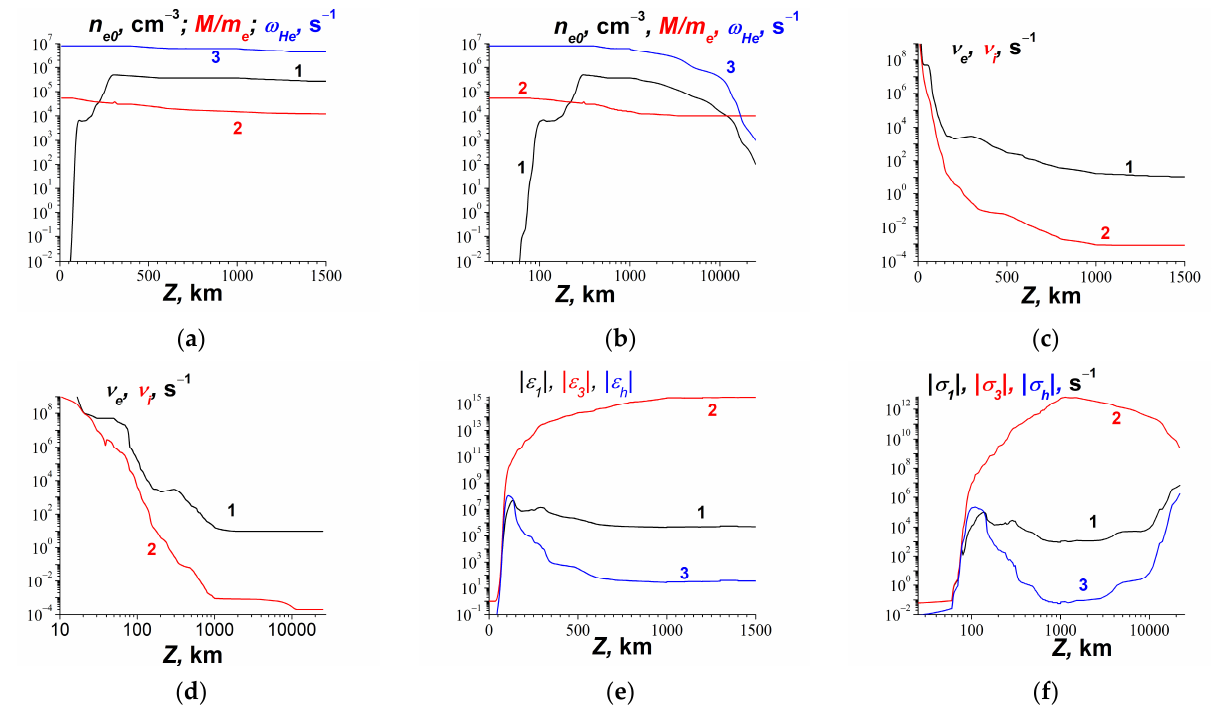
Figure 4. The dependences of the ionosphere and the magnetosphere parameters on height used in simulations. Parts ( a , b ) are dependencies of the electron concentration n e0 , the ratio of the ion mass to electron one, and the electron cyclotron frequency, curves 1, 2, 3. Parts ( c , d ) are dependencies of the electron and ion collision frequencies, curves 1, 2. Parts ( e , f ) are the absolute values of the components of the permittivity and the absolute values of the components of the complex conductivity at the frequency ω = 0.025 s − 1 . Data ate taken from the books [18,51,52,63–65].